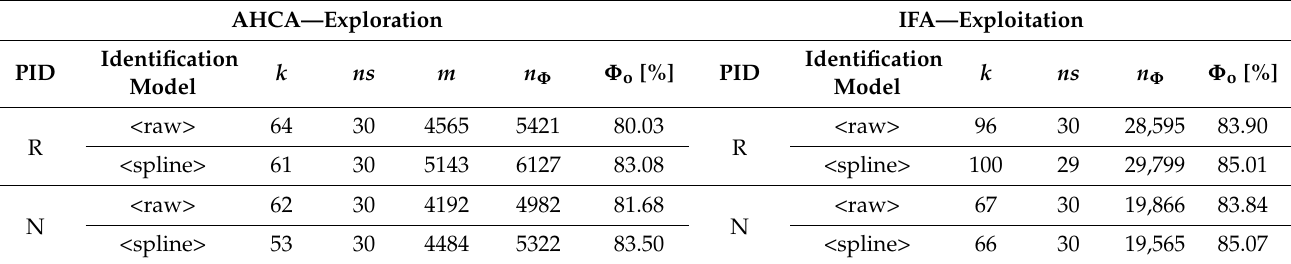
Figure 14. I/O signals for Ziegler–Nichols tuned PID-R controller, in case of <spline> idmo, Φ ZN = 73.12%. Table 4. Running performances of metaheuristics.